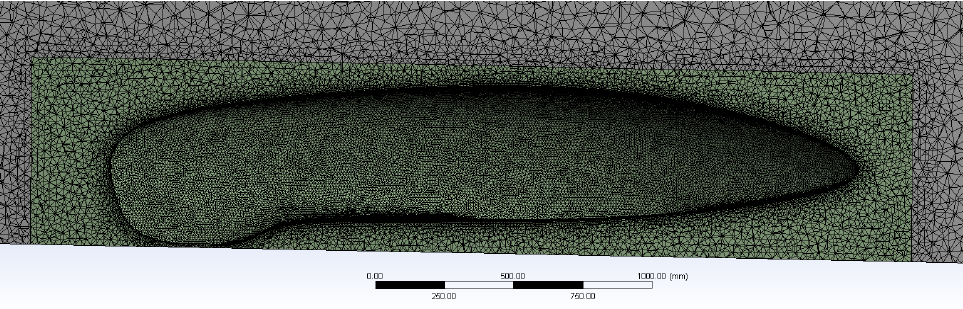
Figure 7. View of the longitudinal section of the mesh.